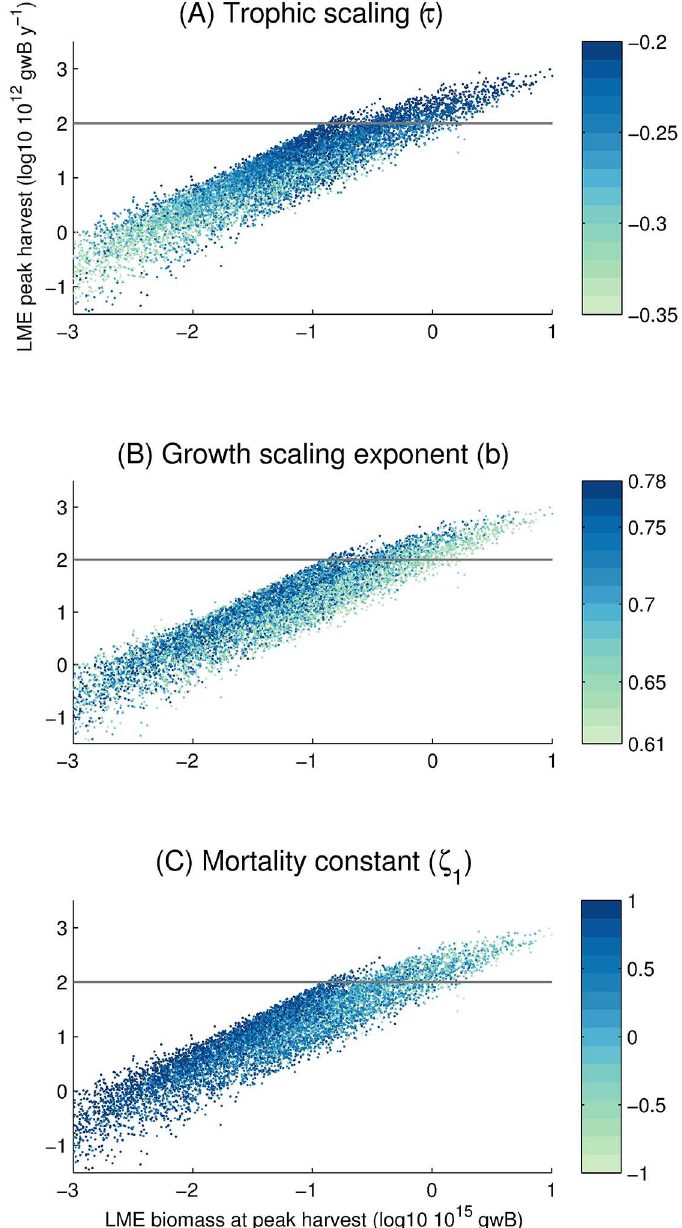
Fig 4. Summary results of Monte Carlo simulations. Horizontaland vertical axes as in Fig 3. Circle color represents (A) Trophic scaling τ , (B) Allometric growth scalingconstant b , or (C) Mortality constant ζ 1 . The grey line represents a reference globalharvest of 100 × 10 12 gwB y − 1